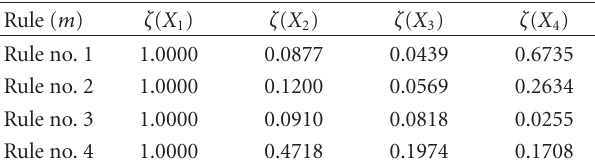
Table 16: Estimated λ -measures.